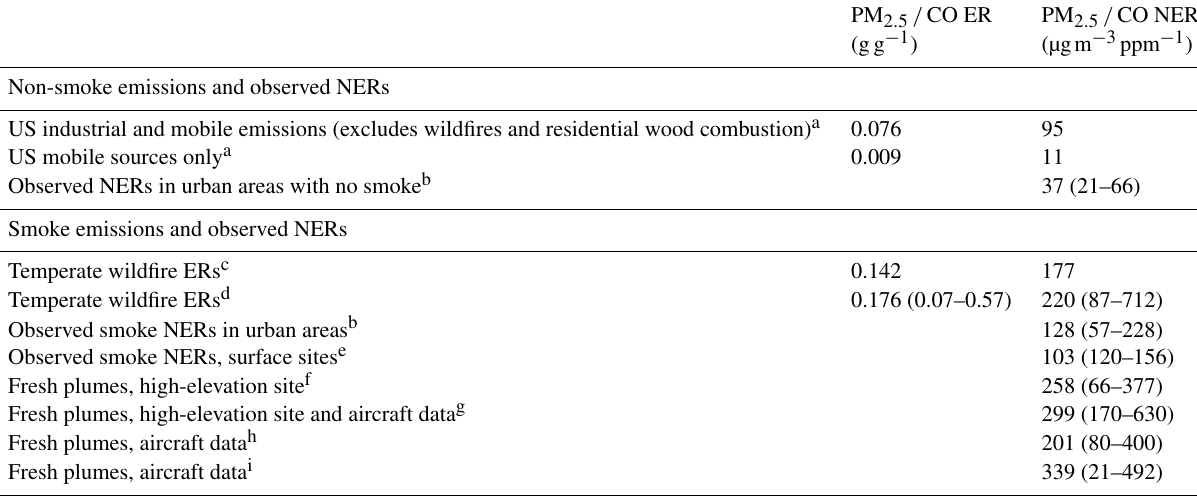
Table 1. Emission ratios (ERs) and observed NERs for non-smoke and smoke conditions. ERs are converted into NERs using a pressure of one atmosphere and temperature of 273K (STP). This calculation assumes no loss of either PM 2 . 5 or CO. For observed ERs and NERs, the study mean is given, with the range (if reported) shown in